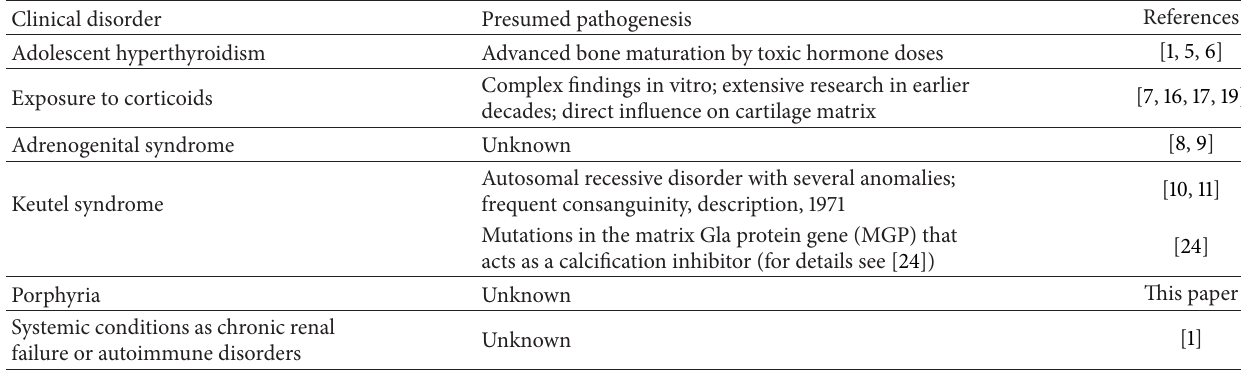
Table 2: Conditions that may lead to premature calcifications of costal